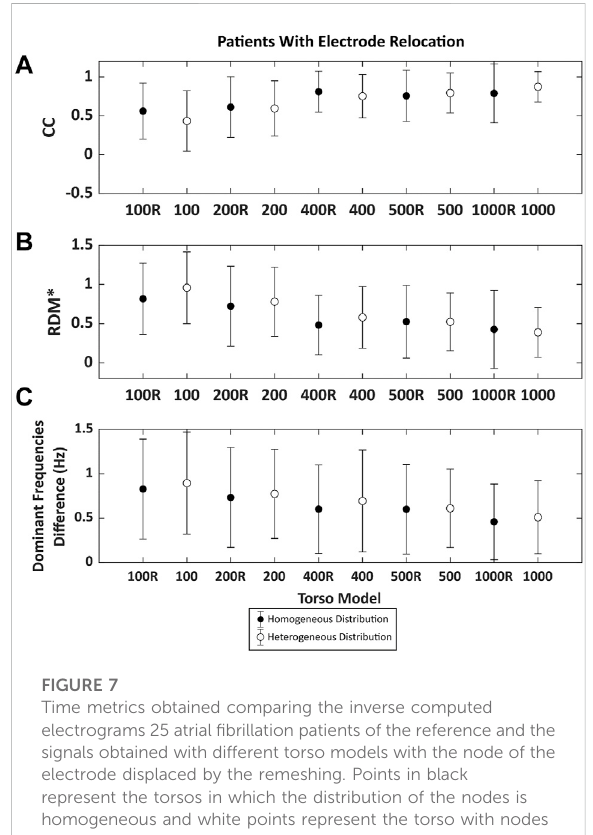
FIGURE 6 (A) . Example of 1 s of inverse computed electrograms obtained with different torso models and the same simulation signals for torsos with the node of the electrode displaced by the remeshing. Signal in black was obtained with the reference 4000-node torso, red and blue signals correspond to the ones obtained with torsos of 2000 and 100 nodes respectively. (B) . Pearson ’ s correlation coef fi cient (CC), (C) . relative measurement (RDM*) and (D) . mean absolute difference between the reference DF between torso models and from 100 to 2000 nodes. Points in black represent the mean value of the metrics torsos in which the distribution of the nodes is homogeneous and white points represent the torso with nodes heterogeneously placed. Whiskers represent the standard deviation.